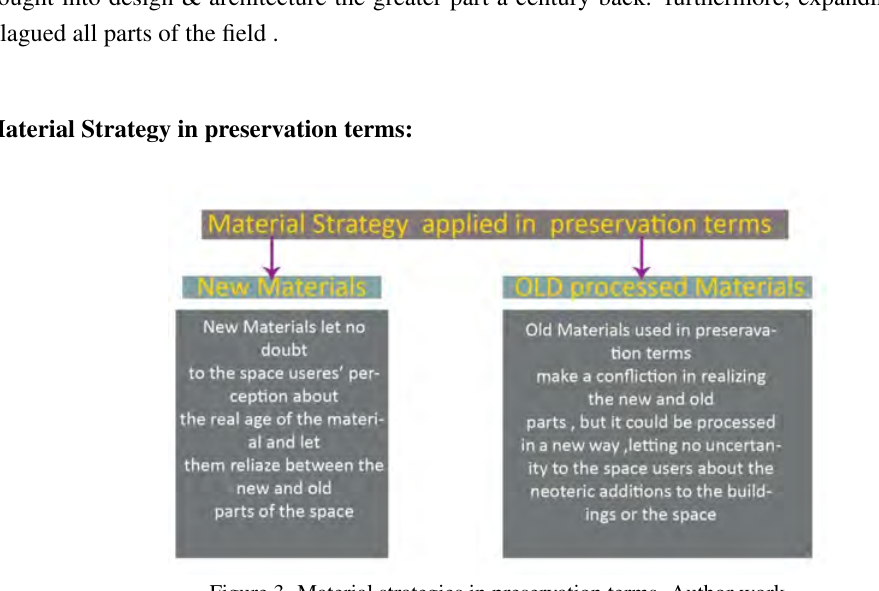
Figure 3. Material strategies in preservation terms. Author work